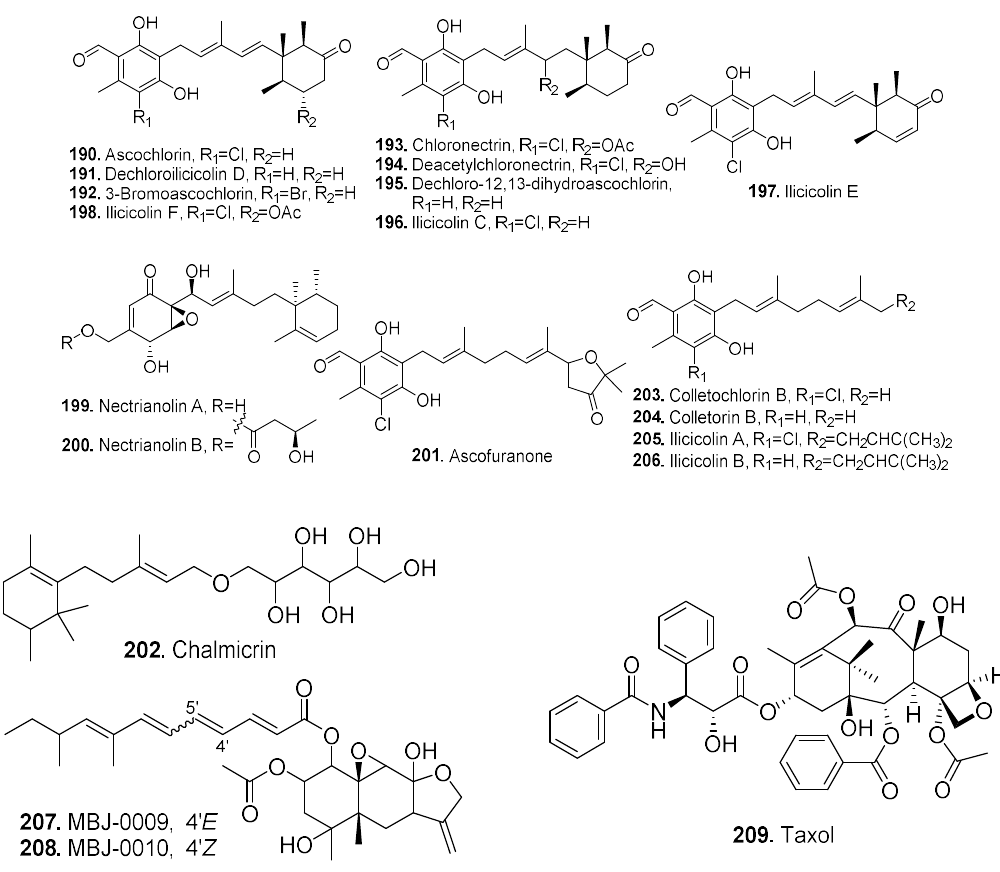
Figure 14. Meroterpenoids isolated from Clonostachys fungi.